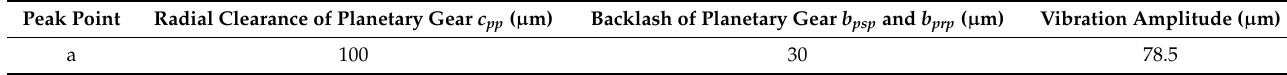
Table 9. The peak value of torsional vibration for antenna reflector in Figure 16. Table 8. The peak value of radial vibration for antenna reflector in Figure 15.